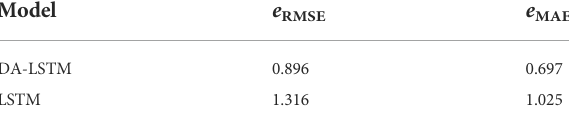
TABLE 3 The performances of different